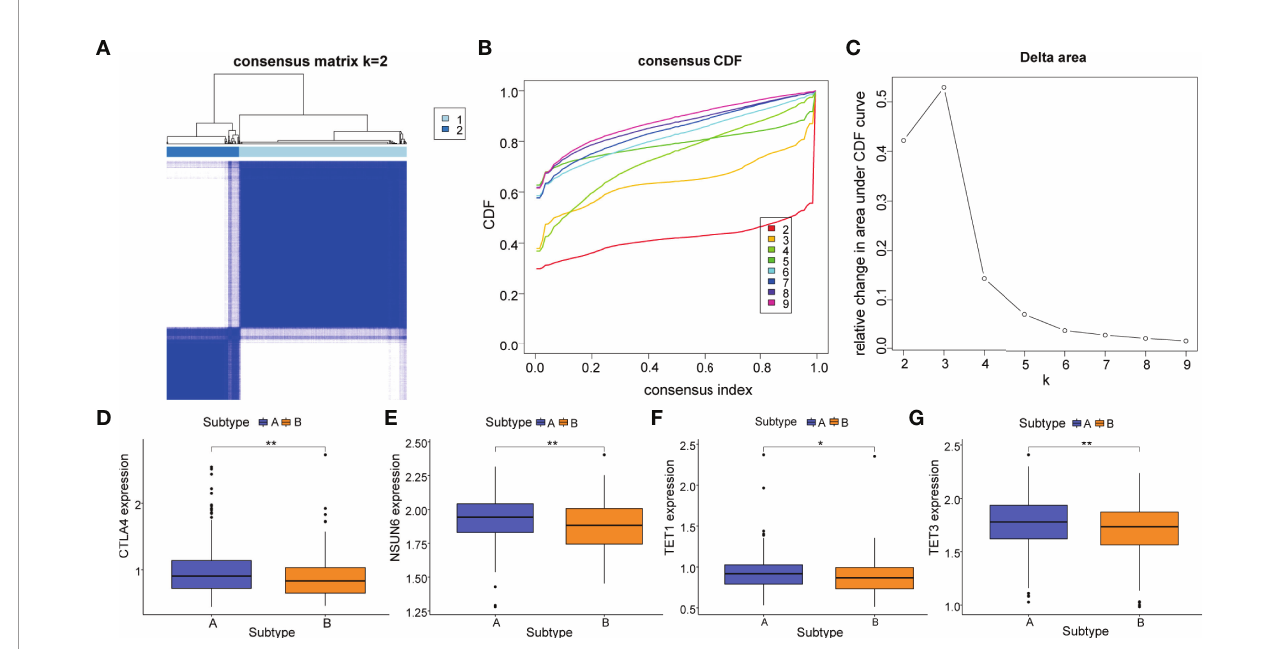
FIGURE 8 | m5C immune subtypes based on key immune cell phenotypes. (A) The PCa patients were strati fi ed into 2 subtypes based on the consensus clustering matrix (k = 2). (B, C) Consensus clustering model with cumulative distribution function (CDF) by k from 2 to 9. (D) The gene mRNA expressions of the immune checkpoint gene CTLA4 between m5C immune subtype A and m5C immune subtype. The gene mRNA expressions of m5C regulatory genes including (E) NSUN6, (F) TET1, and (G) TET3 between m5C immune subtype A (subtype A, blue) and m5C immune subtype B (subtype B, yellow). P-values were shown as follows: *P < 0.05 and **P <